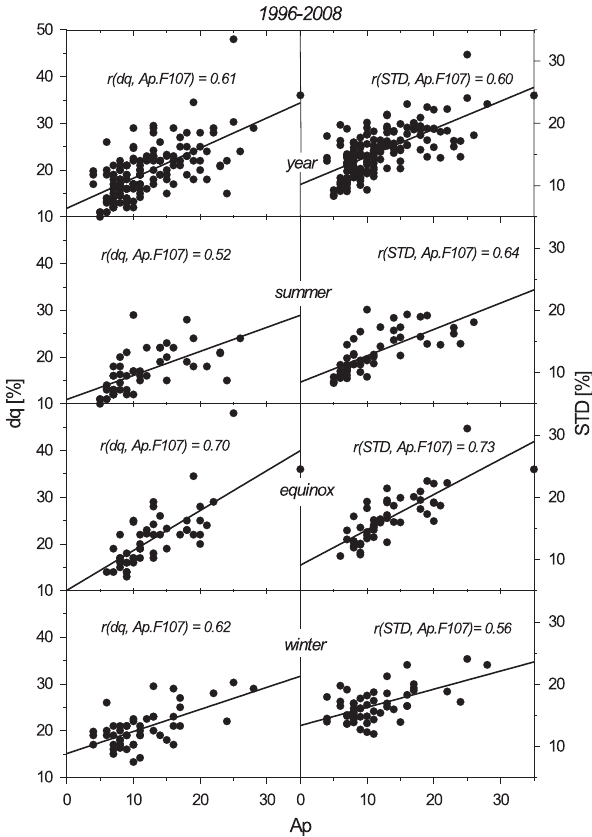
Fig. 13. Dependence of monthly quartile differences dq (left part) and standard deviations STD (right part) on geomagnetic activity for all median values as well as separately for different seasons. The black lines are simple regression lines whereas the included values are partial correlation